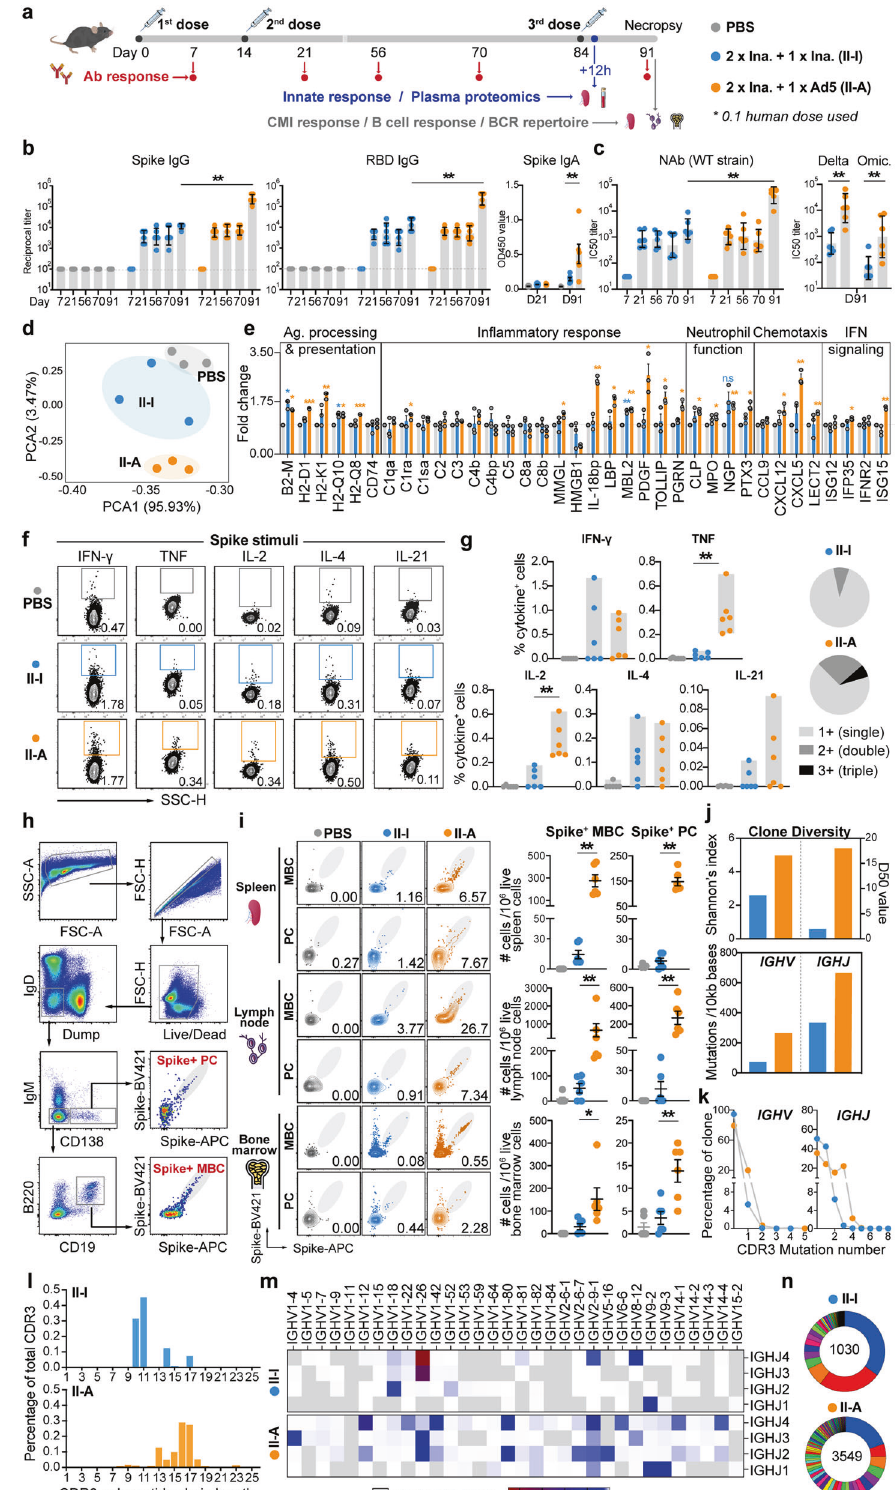
dominant BCR clones in each vaccine group were also identi fi ed and a marked increase in BCR clonality was observed in mice receiving heterologous booster (Fig. 1n). The Ig kappa ( κ ) and lambda ( λ ) light chains were also sequenced. For Ig λ repertoire, IGLV1-IGLJ1 represented the most frequently used pair accounting for